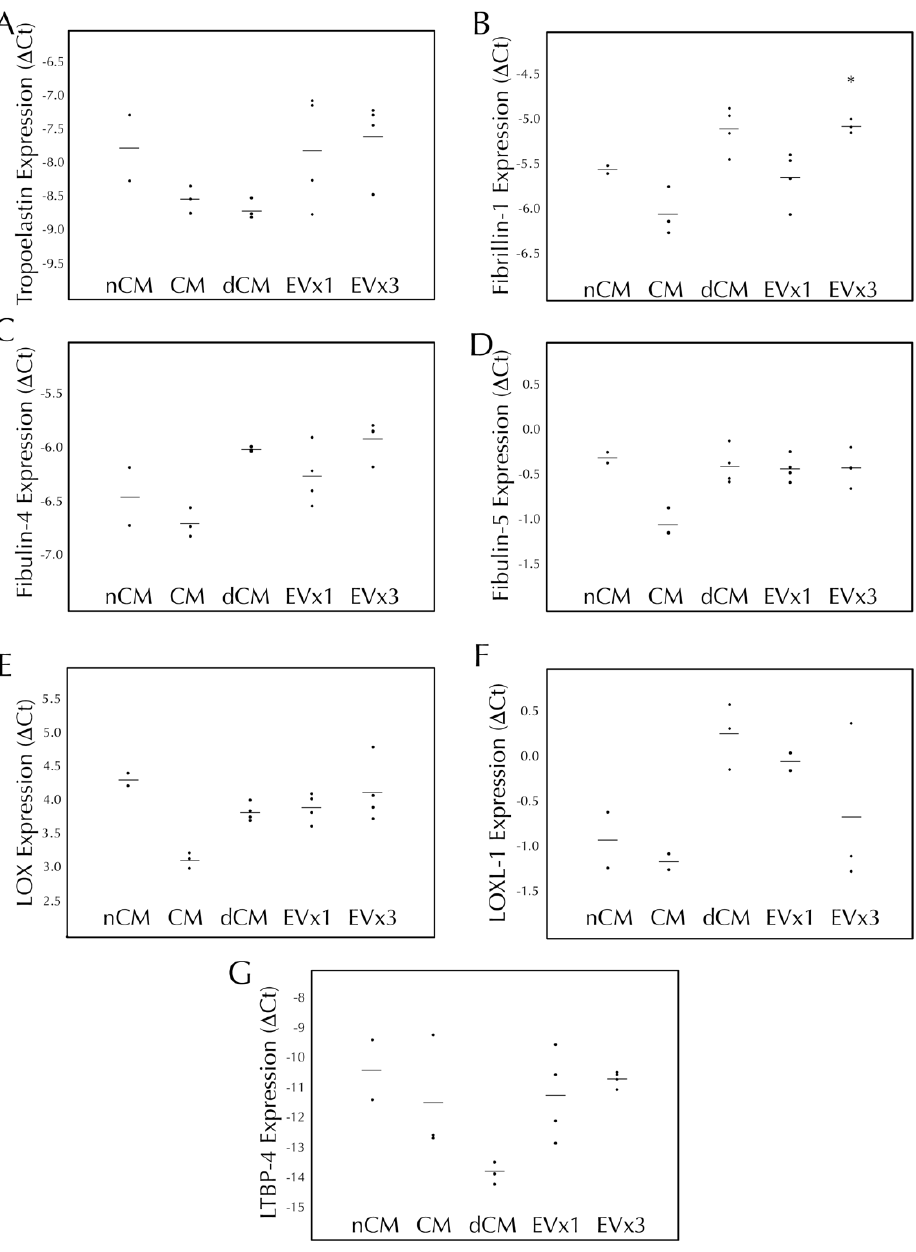
Figure 2. 3 × EV treatment of discs lead to increased transcription of fibrillin-1 after 30 days of culture. Fibrin discs were cultured for 30 days using treatments replenished every 48–72 h, subjected to RNA extraction, and analyzed by RT-qPCR for expression of human ( A ) tropoelastin, ( B ) fi-brillin-1, ( C ) fibulin-4, ( D ) fibulin-5, ( E ) lysyl oxidase (LOX), ( F ) lysyl oxidase-like 1 (LOXL-1), and ( G ) latent TGF- β binding protein-4 (LTBP-4). Treatment groups were non-conditioned media (nCM), ASC conditioned media (CM), CM depleted of EVs (dCM), 1 × extracellular vesicle treatment (EV × 1), or 3 × EV treatment (EV × 3). Gene expression was expressed as ∆ Ct relative to the housekeeping gene GAPDH, where higher values relative to nCM indicate higher expression levels. For all groups, the individual data points are plotted as dots, with a line indicating the average value. * = p < 0.05 relative to